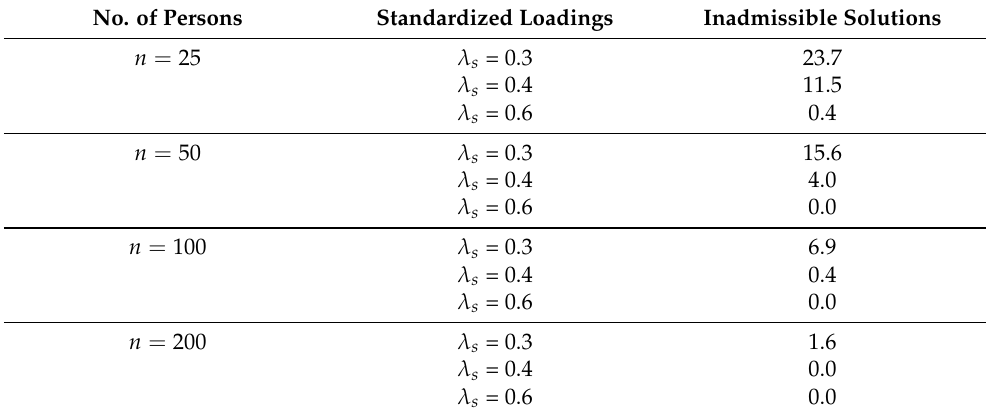
Table 1. Simulation study results: Percentages of inadmissible solutions for M plus ’ default procedure. No. of